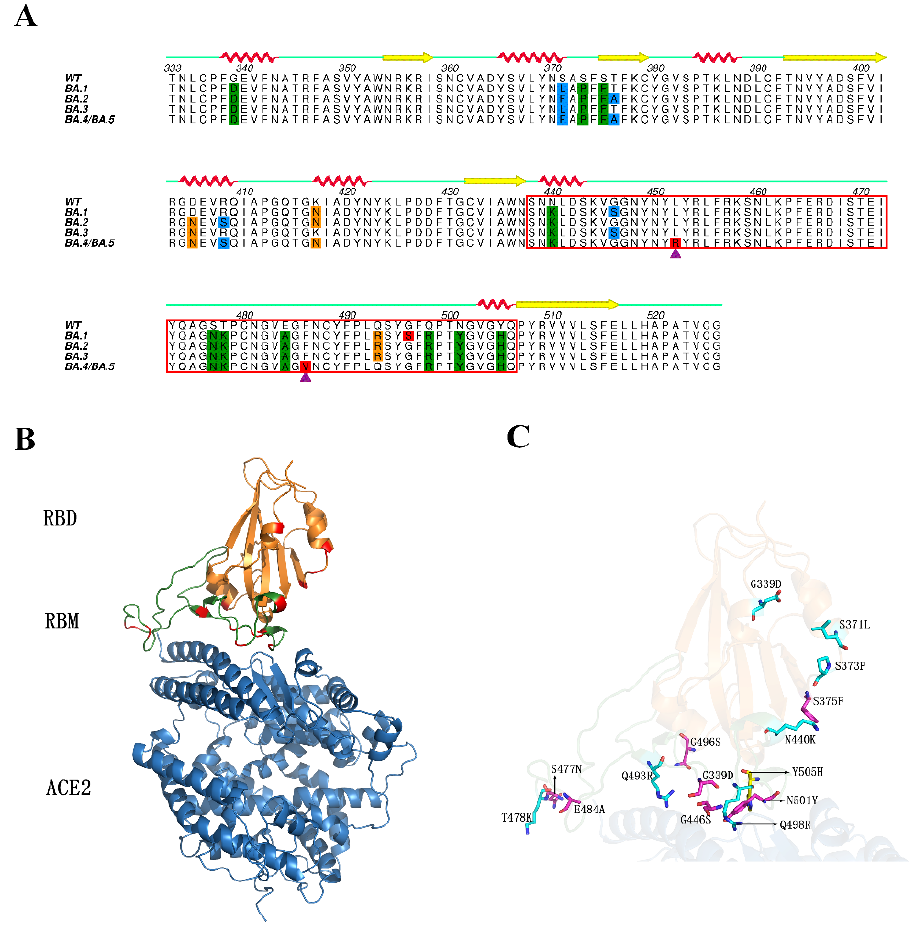
Figure 1. Multiple sequence alignment of RBD WT and RBD OMI s, and 3D structures of RBD BA.1 -ACE2 complex. ( A ) Multiple sequence alignment of RBD WT and RBD OMI s. The residues with mutations existing in four, three, and two subvariants, and residues harboring unique mutation, are colored green, orange, blue and red, respectively. The L452R and F486V mutations, existing only in RBD BA.4/5 , are indicated by purple triangles. RBM is highlighted by a red box. Secondary structures are illustrated above the corresponding amino acid sequence (red helix: α -helix; yellow arrow: β - sheet), and residue numbers are indicated above the primary sequence. ( B ) Ribbon representation of 3D structure of RBD BA.1 -ACE2 complex (modeled on the crystal structure with PDB ID 6M0J [5]). ACE2 is colored blue. Core and RBM of RBD BA.1 are colored orange and green, respectively. The residues with mutations are highlighted in red. ( C ) Close-up view of RBD BA.1 bound to ACE2. The residues with mutations are represented as a stick model. ( A ) was generated using Aline [12], ( B , C ) were generated using Pymol